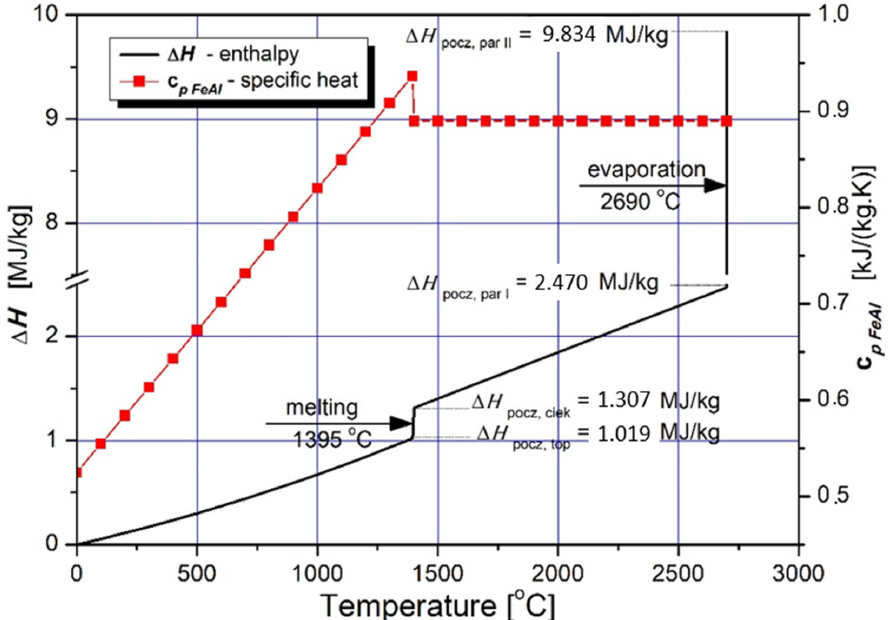
Figure 3. Dependence of the specific enthalpy of FeAl on the temperature (continuous line) obtained from model calculated dependence of the specific heat at the constant pressure with consideration of the value of enthalpy of phase changes of melting and evaporation (in accordance with Table 5). Specific enthalpy is the main parameter that determines the amount of energy required for isobaric heating, melting and evaporating the powder feedstock material as a function of temperature. Despite the fact that the FeAl phase is stable up to 1310 °C (Figure 4), the first temperature range was selected to be from 0 °C to 1395 °C, which is the model liquidus temperature for the Fe40Al at.% alloy. The second range from 1395 °C to the conventional evaporation temperature of 2690 °C was determined on the basis of the arithmetic mean of the evaporation temperatures of Al and Fe [30–35].